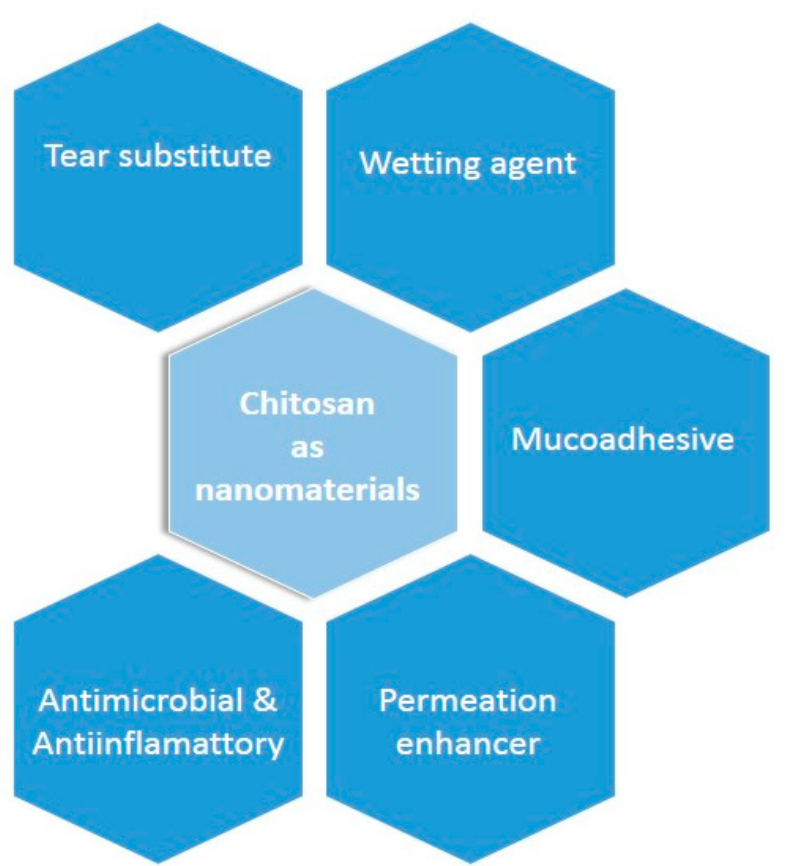
Figure 3. The characteristics that make chitosan a nanomaterial and a promising candidate for nan- otechnology-mediated ocular drug delivery in glaucoma.